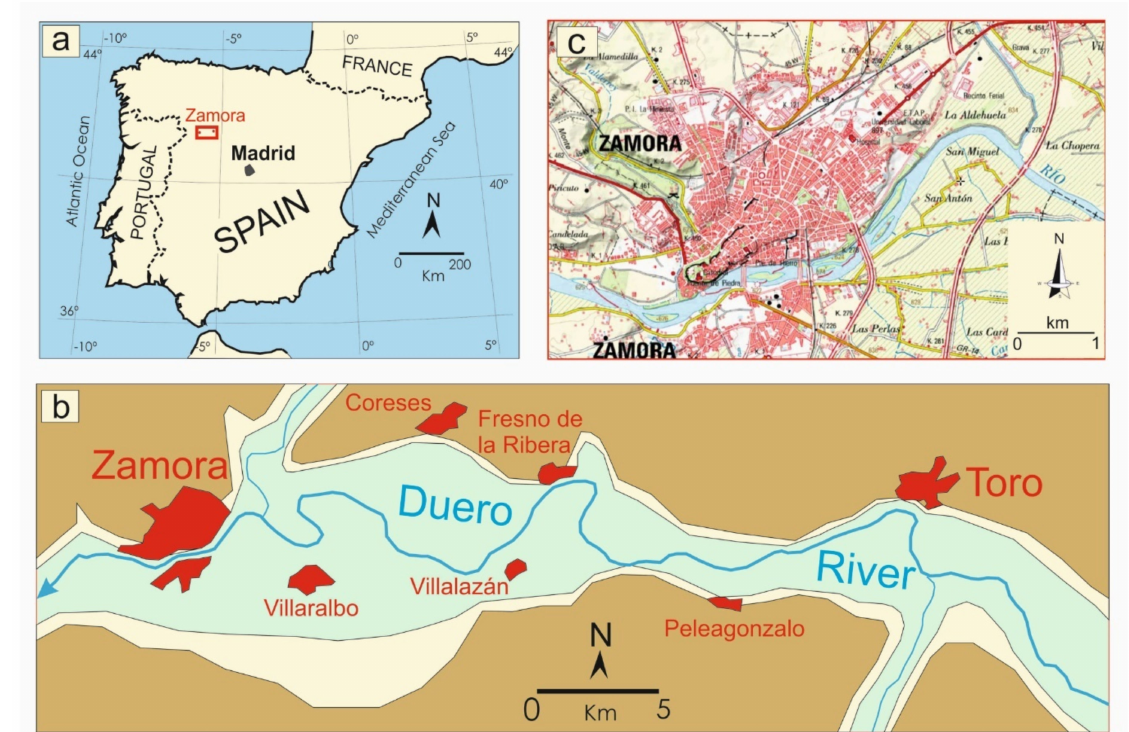
Figure 1. Map of the study area (Zamora city) describing its location ( a ), the main shape of the Douro River valley and floodplain ( b ), and the distribution of the urban area of the city ( c ). Source of data for ( c ) is the Iberpix geographic viewer from the Instituto Geogr á fico Nacional of